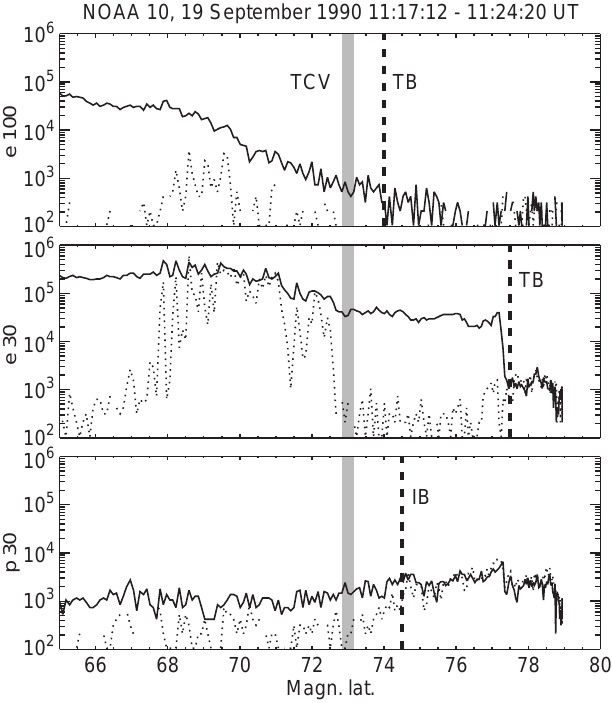
Fig. 2. MEPED data from NOAA 10 for the dayside northern polar crossing on September 19, 1990, which crosses the latitude of the TCV event at approximately 1120 UT, 10 MLT. Each panel displays the measured directional particle flux, in units of 1 = cm 2 sster , on a logarithmic scale as a function of corrected magnetic latitude for the two sets of directions: the dotted line is the flux approximately along the magnetic field lines (precipitating), and the full line is the flux close to perpendicular to the field lines (trapped). The top two panels are for electrons of energies > 30 keV and > 100 keV, respectively. The vertical lines labelled TB mark the latitude of the identified trapping boundaries. The bottom panel is for protons of > 30 keV, and the vertical line labelled IB marks the latitude of the determined proton isotropy boundary. The bar labelled TCV through all panels marks the determined latitude of the TCV centres for